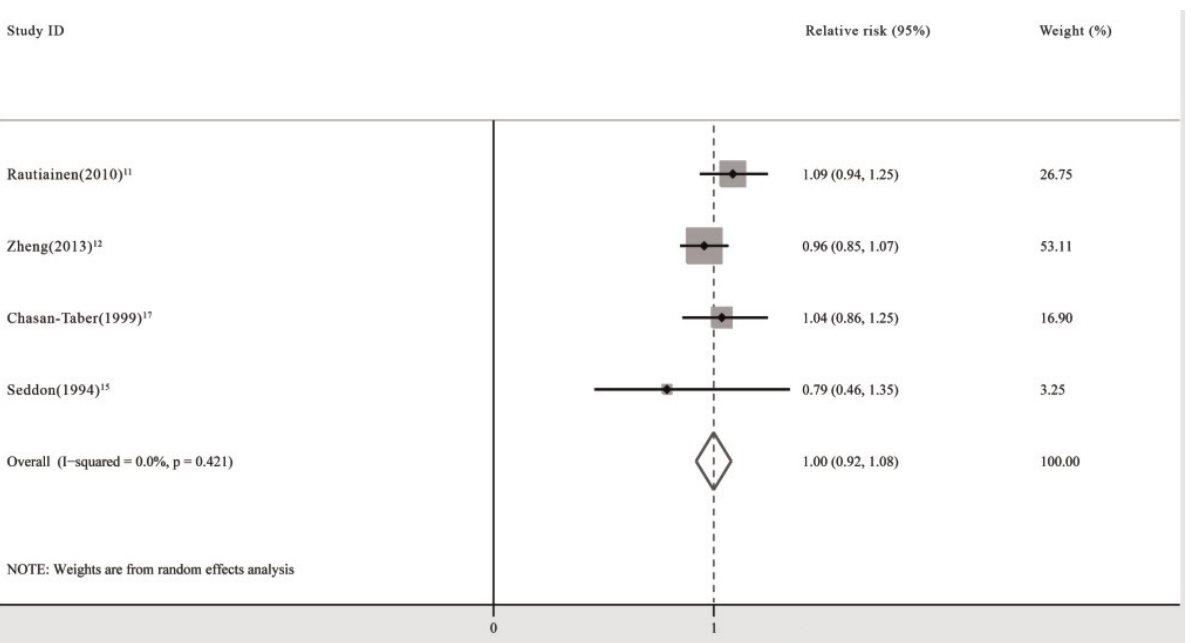
Figure 6. Pooled relative risk (95% CI) of requiring cataract surgery comparing the longest duration of multivitamin/mineral supplementation with no